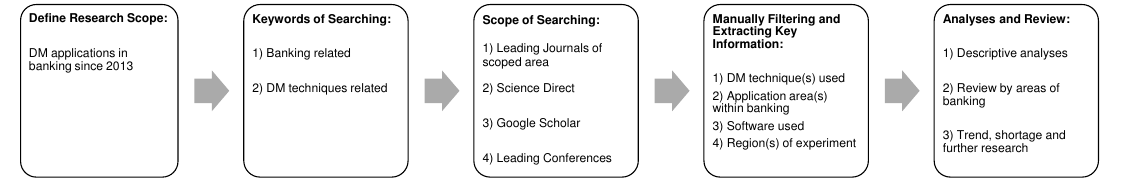
Figure 1. Research framework for DM applications in